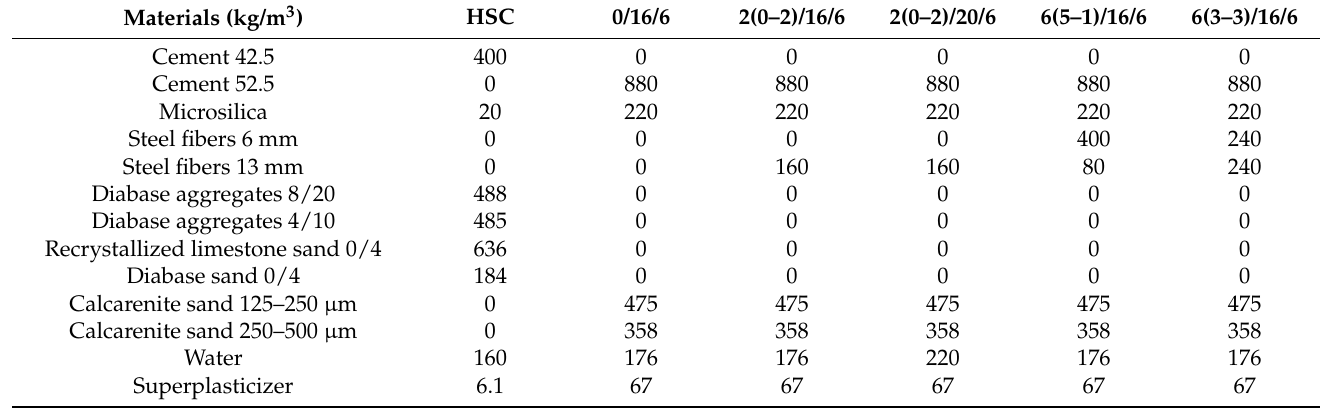
Table 1. Mixture design.